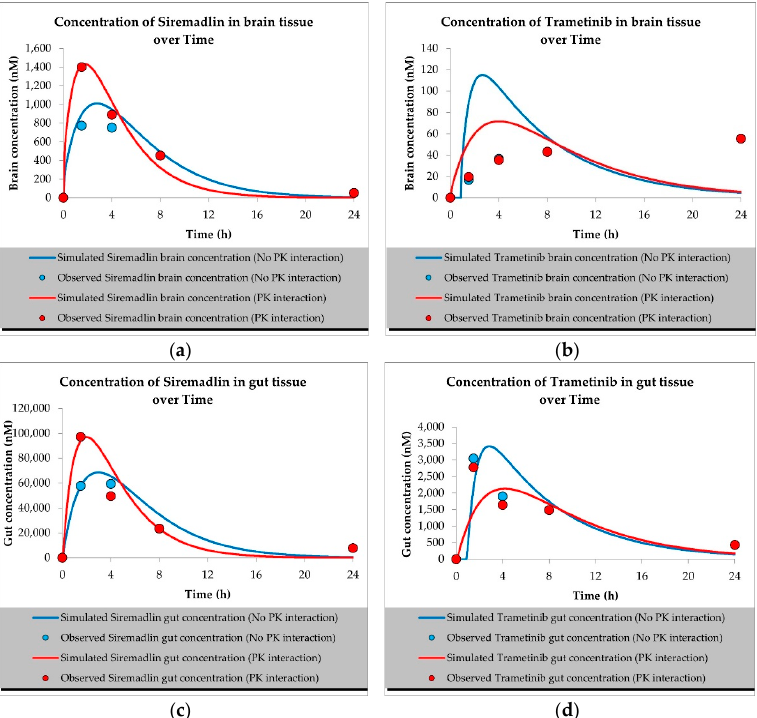
Figure 3. Values of predicted concentrations with and without PK interaction for ( a ) siremadlin and ( b ) trametinib in brain tissue; ( c ) siremadlin and ( d ) trametinib in gut tissue; observed data are means from n = 3.